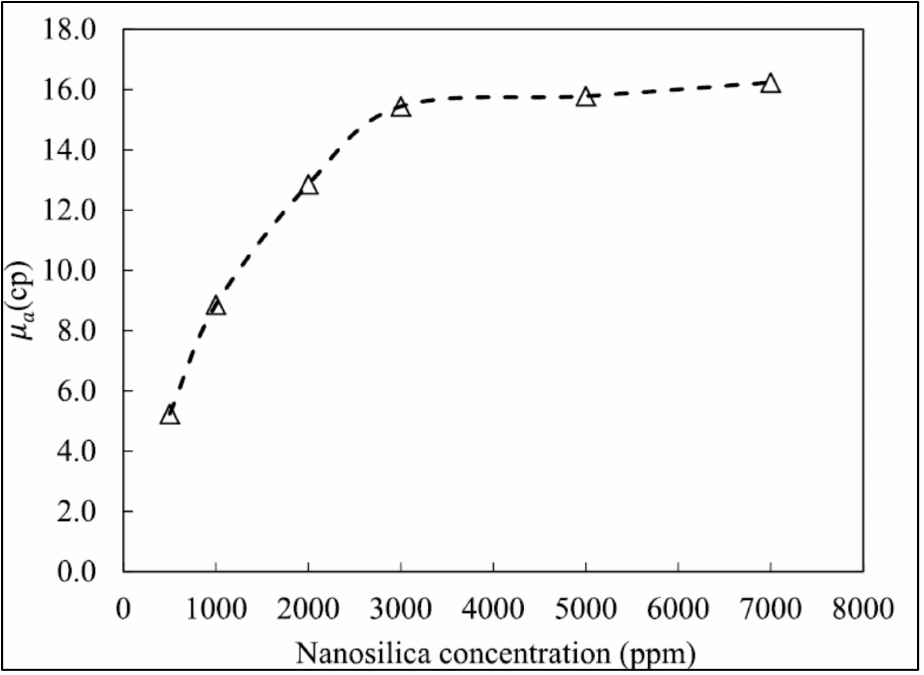
Figure 23. Effect of nano-silica concentration on foam apparent viscosity. The apparent viscosity is related to the intrinsic shear rate at the capillary wall. (Reprinted with permission from Fu & Liu, [56]). Copyright 2020, Elsevier